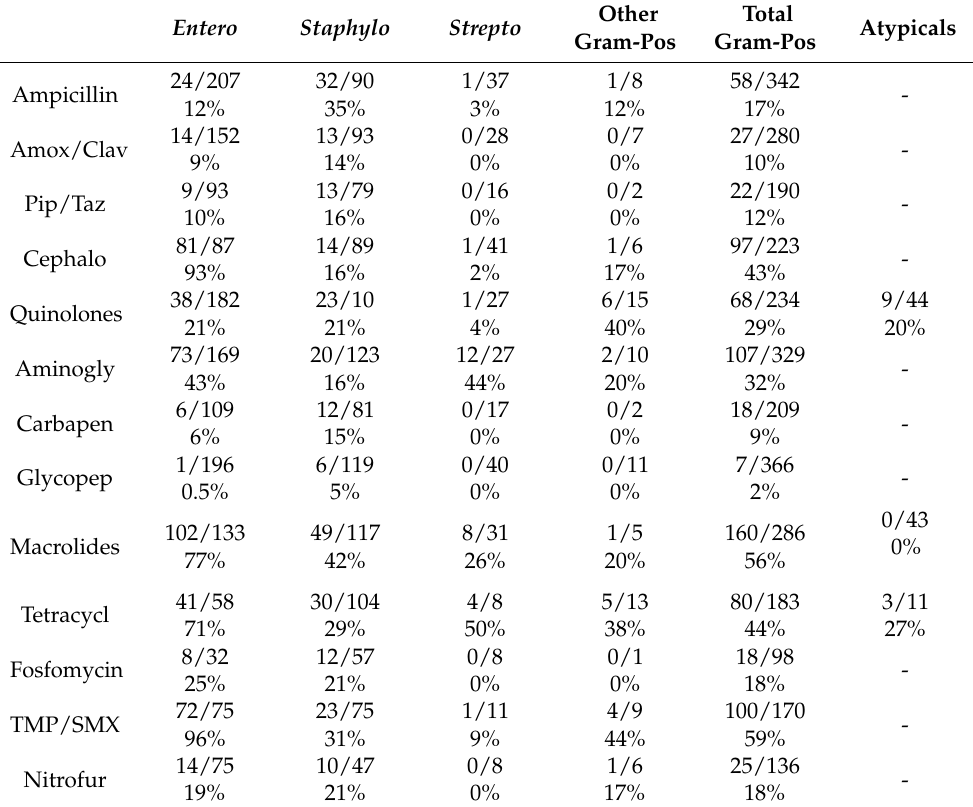
Table 2. Resistance rates of Gram-positive and atypical